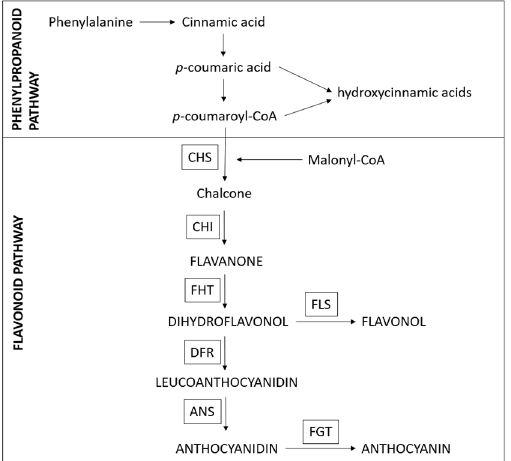
Figure 1. Simplified synthetic pathway of anthocyanins in the fruits of berry species. PAL—phenylalanine ammonia lyase; CHS—chalcone synthase; CHI—chalcone isomerase; FHT—flavanone 3-hydroxylase; DFR, dihydroflavonol 4-reductase; ANS—anthocyanidin synthase; FLS—flavonol synthase; FGT—flavonoid 3- O -glucosyltransferase [12,13].